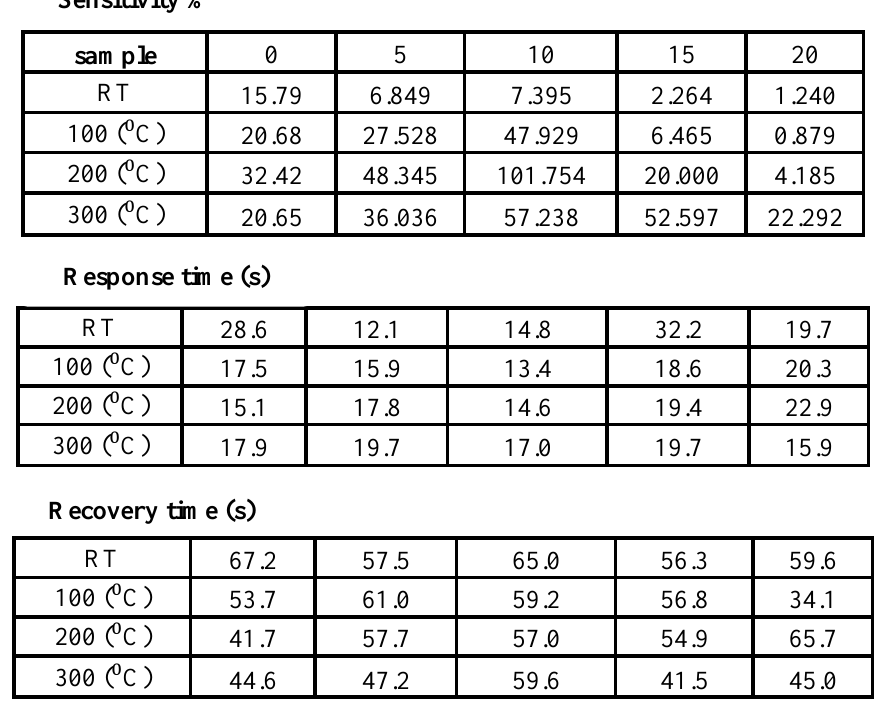
Table 5: Response time, recovery time and sensitivity of un-doped SnO different ratio of (5, 10, 15, 20)ml